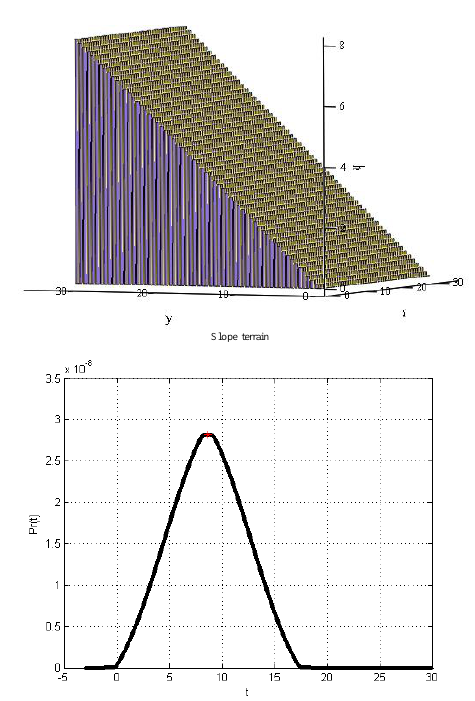
Figure 2. The slope model and its echo signal. The power of an echo signal is similar to a Gaussian function of an independent variable. The function is continuous and has a peak value in the time interval (where max h represents the height of the highest point of the h represents the height of slope of the laser footprint, and min the lowest point of the slope of the laser footprint).